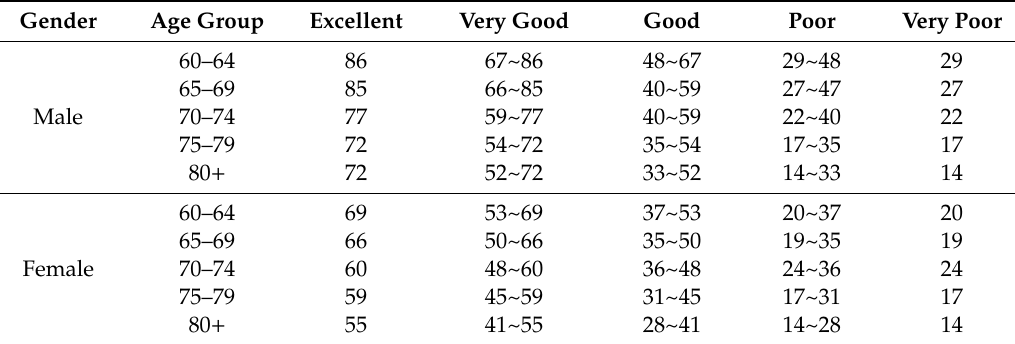
Table 19. Two-minute steps 5-grade relative evaluation norms, Unit: